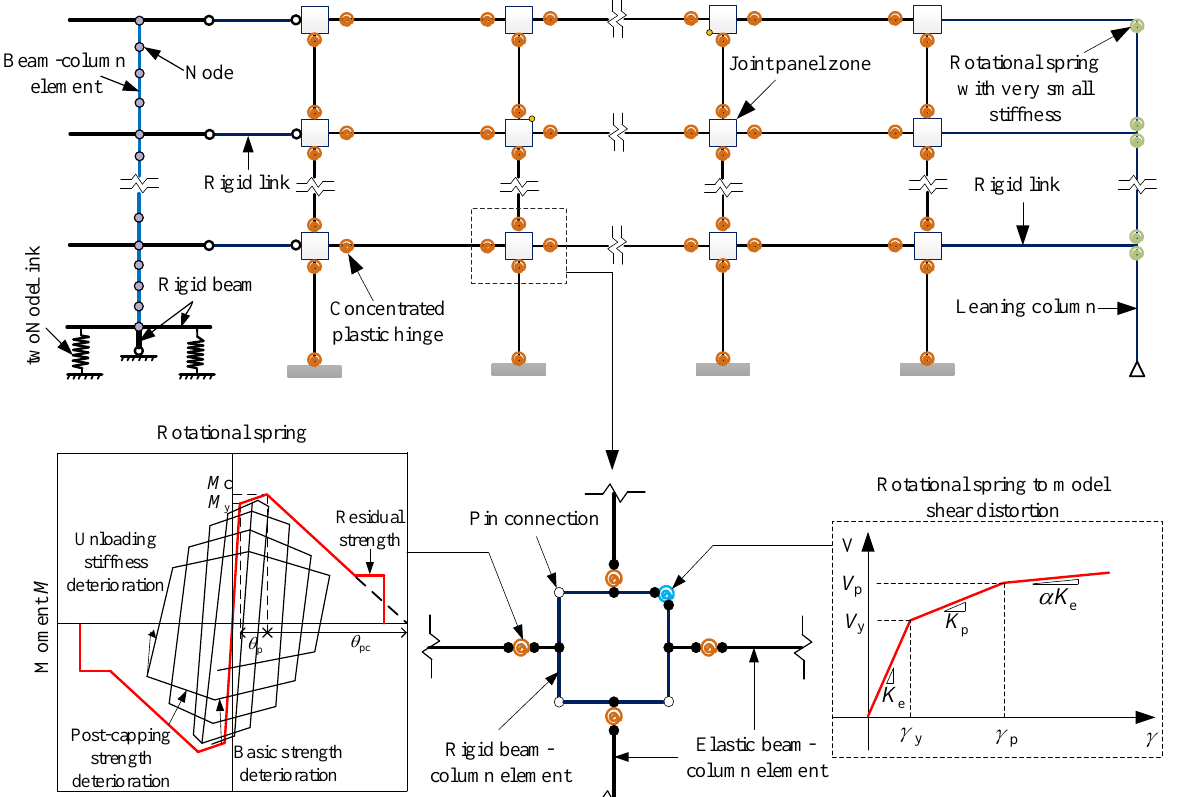
Figure 13. Numerical modeling for PSCRSW.